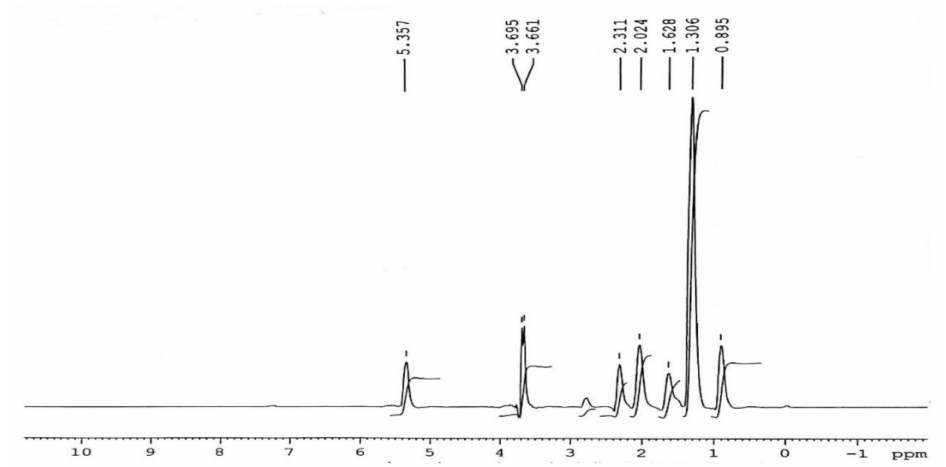
Figure 18. 1 H-NMR spectrum of Prunus aitchisonii biodiesel treated with TiO 2 .